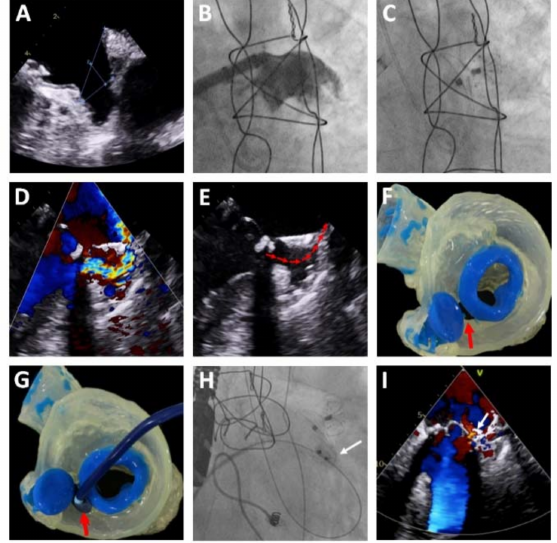
Figure 1. Case of left atrial appendage closure (LAAC) with the LAmbre™ device showing the resistance of the device to direct impact from a severe regurgitation jet from a mitral periprosthetic leak. Legend: ( A – C ) device implantation. ( D , E ) transesophageal echocardiography (TEE) showing a regurgitation jet from the leak toward the device, flowing between the cover disk and the umbrella (red arrow). ( F , G ) 3D model for planning of the percutaneous closure of the leak (red arrow). ( H ) Percutaneous closure of the leak with a 14 × 5 mm Amplatzer Vascular Plug III device (Abbott Vascular, USA) (white arrow). ( I ) TEE confirming the correct implantation of the device (white arrow) with no interference with the LAAC system or with the cusps of the mitral bioprosthesis, reducing the regurgitation to mild.